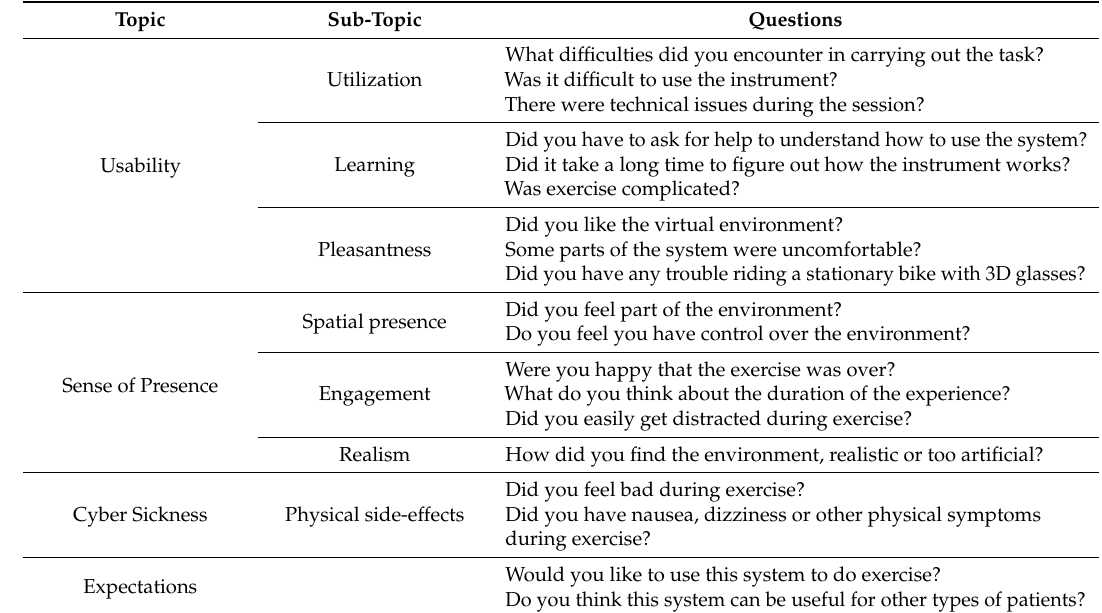
Table 1. Questions of semi-structured